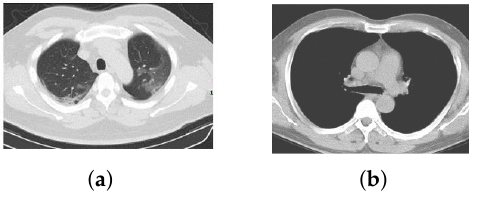
Figure 2. Dataset CT images: ( a ) COVID-19, ( b )